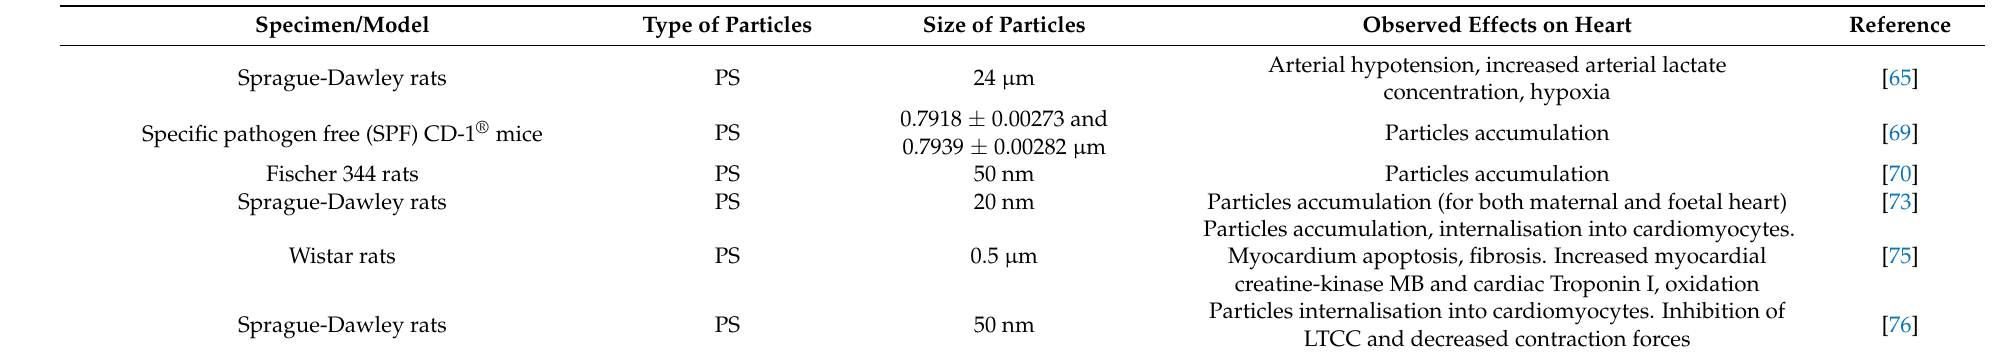
Table 4. Table summarising the main features and effects of MPs/NPs on mammalian cardiac tissue and cardiomyocytes. PS: polystyrene; LTCC: L-type calcium